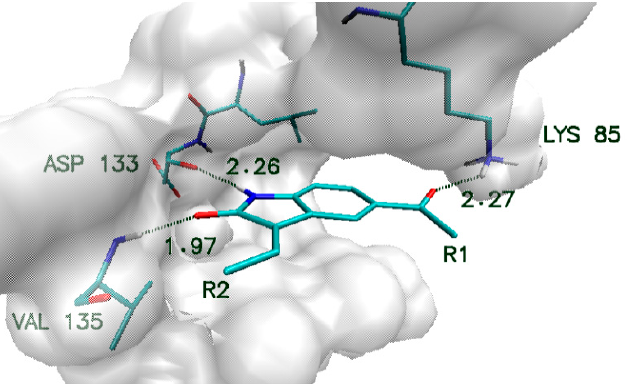
Figure 1. Characteristic interactions of the oxindole core with amino acids from GSK-3 β active site.